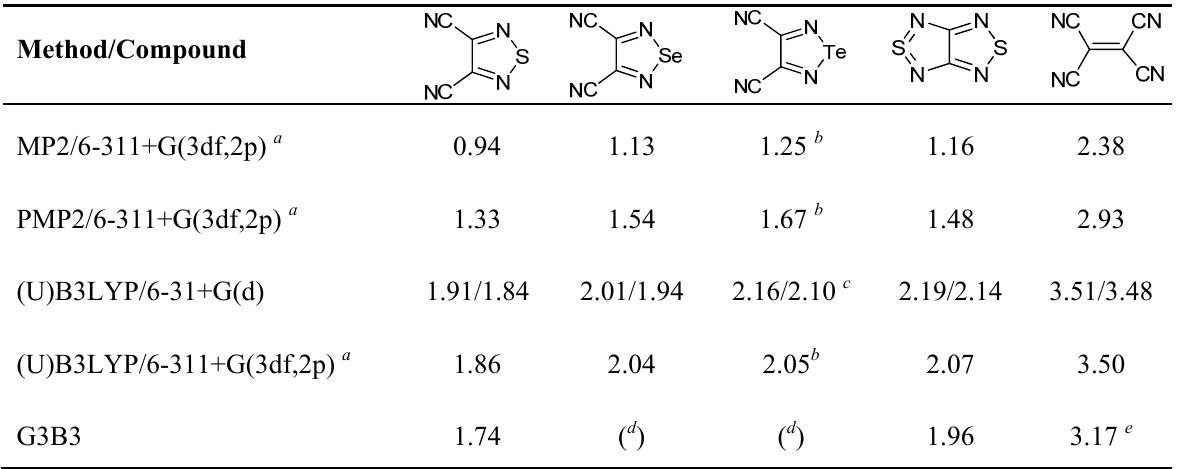
Table 1. Adiabatic EA (eV) of referent compounds calculated with/without ZPE correction [89].